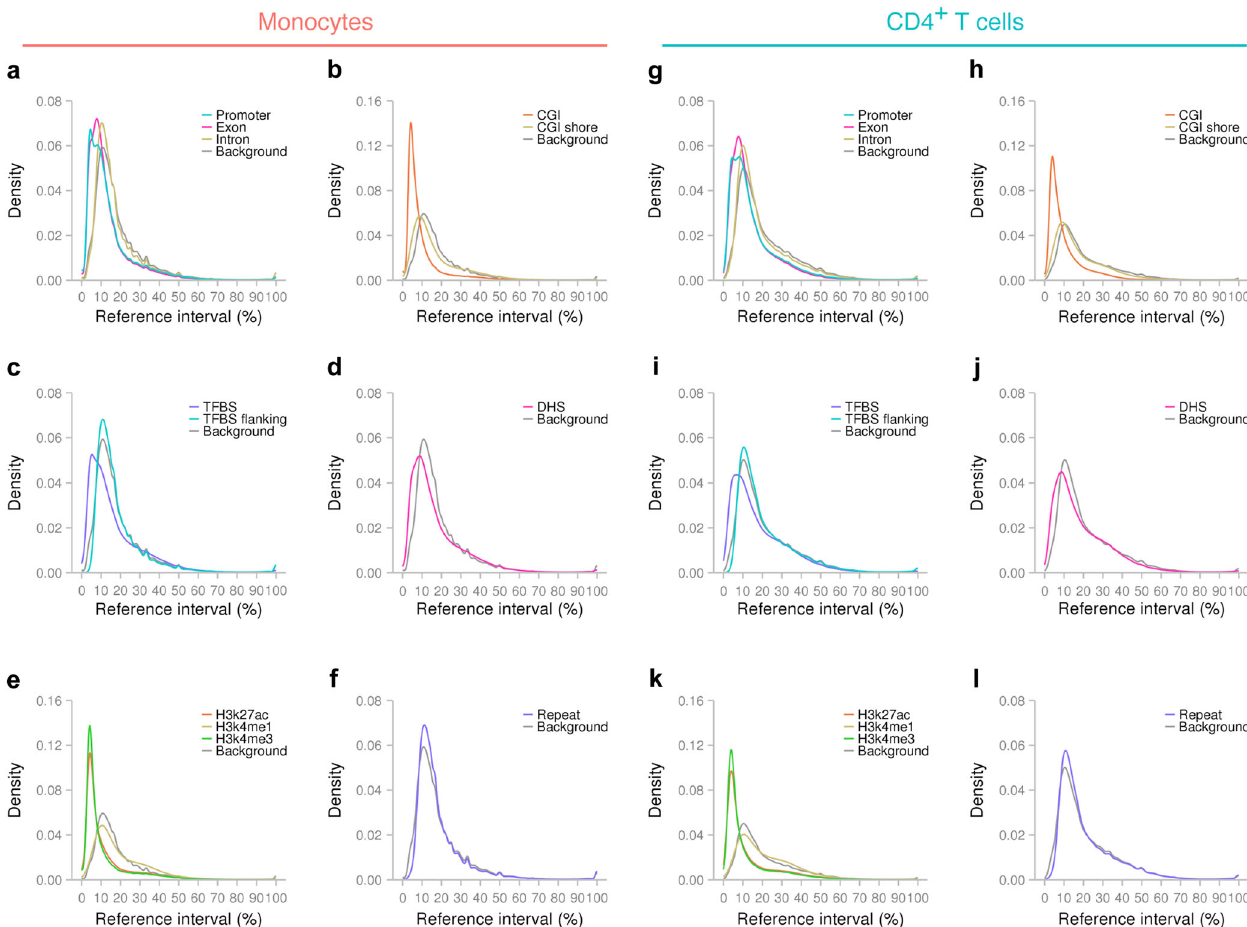
Fig. 6 DNAm variability for regulatory elements. Distributions of reference intervals in monocytes a – f and CD4 + T cells g – l . Background distributions are based on the ~24 million CpG sites included in our comprehensive DNAm pro fi les. CGI CpG island, DHS DNase I- hypersensitive site, H3K27ac histone H3 acetyl Lys27, H3K4me1 histone H3 monomethyl Lys4, H3K4me3 histone H3 trimethyl Lys4, TFBS transcription factor binding